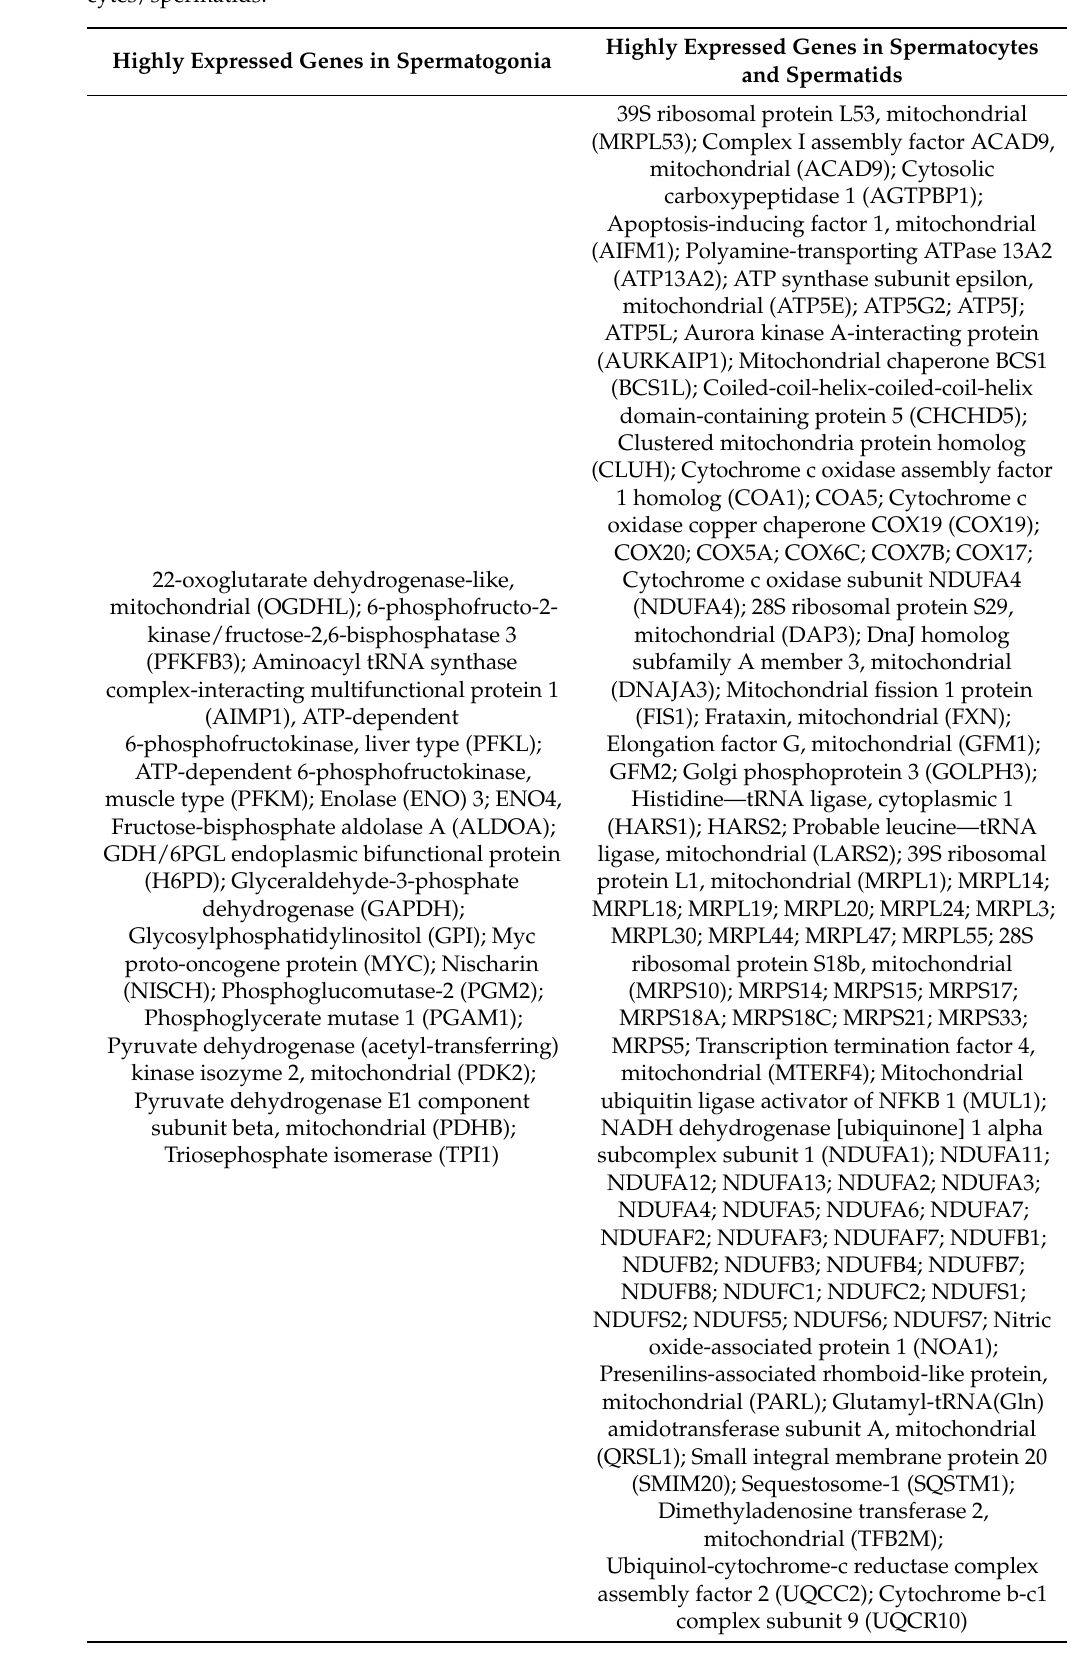
Table 1. Summary of differentially expressed genes between spermatogonia and spermato-